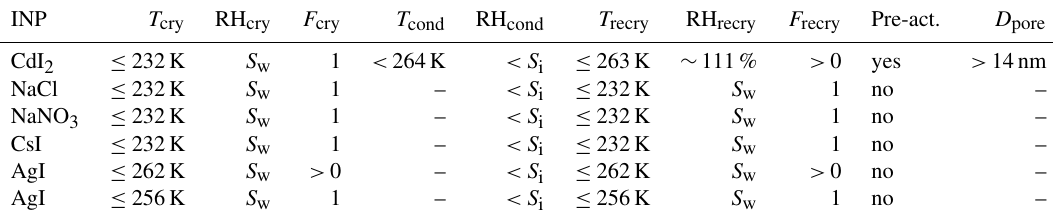
Table 1. Expansion chamber experiments by Fournier d’Albe (1949). T cry – first crystallization temperature; RH cry – first crystallization RH; F cry – crystallized fraction of cloud droplets at S w or activated fraction of particles below S w ; T cond – conditioning temperature; RH cond – conditioning RH; T recry – recrystallization temperature; RH recry – recrystallization RH with respect to ice; F recry – recrystallized fraction of cloud droplets at S w or activated fraction of particles below S w ; D pore – pore diameter needed to prevent ice from melting; S w – water saturation; S i – ice saturation.